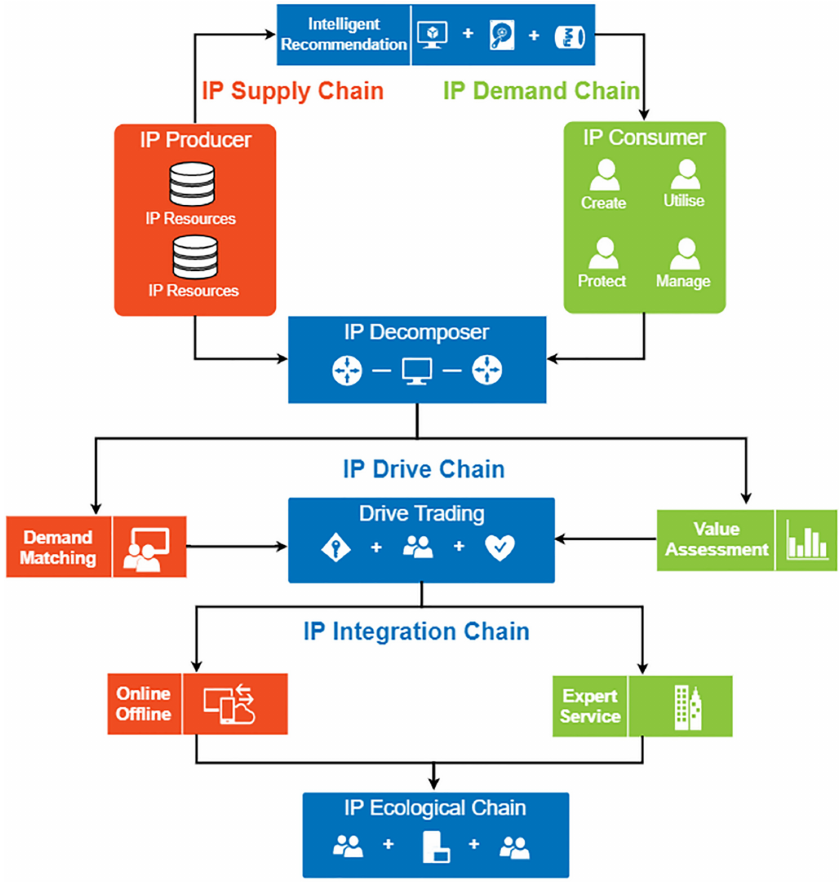
Figure 1. IP ecological chain